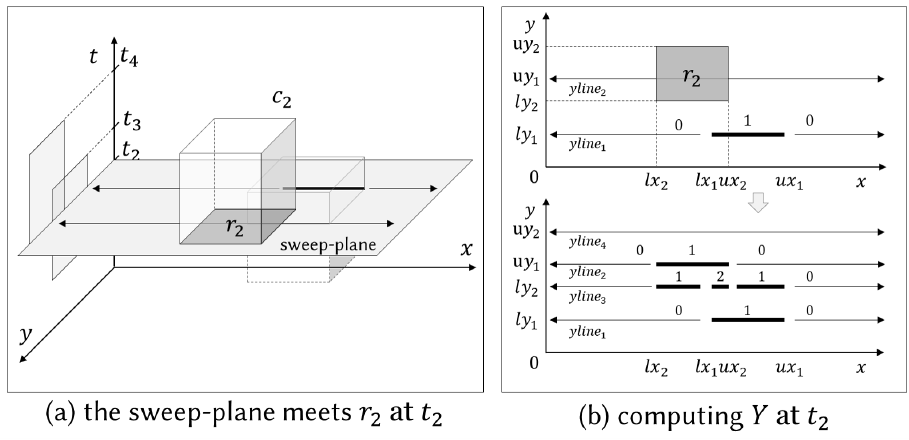
Figure 6. Sweep-plane encounters r 2 at t 2